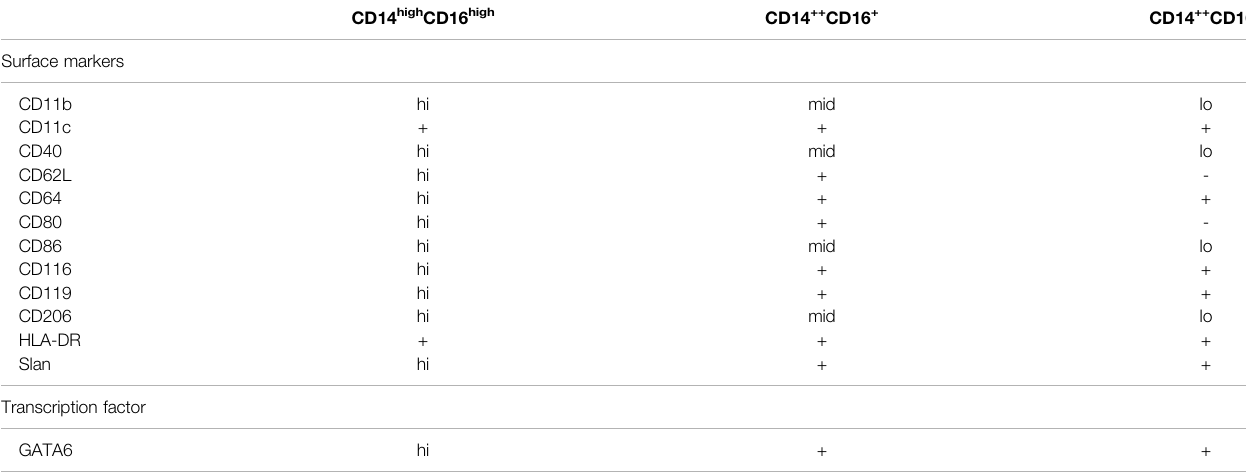
TABLE 2 | Characteristics of PRMs in human (Ruiz-Alcaraz et al., 2018).